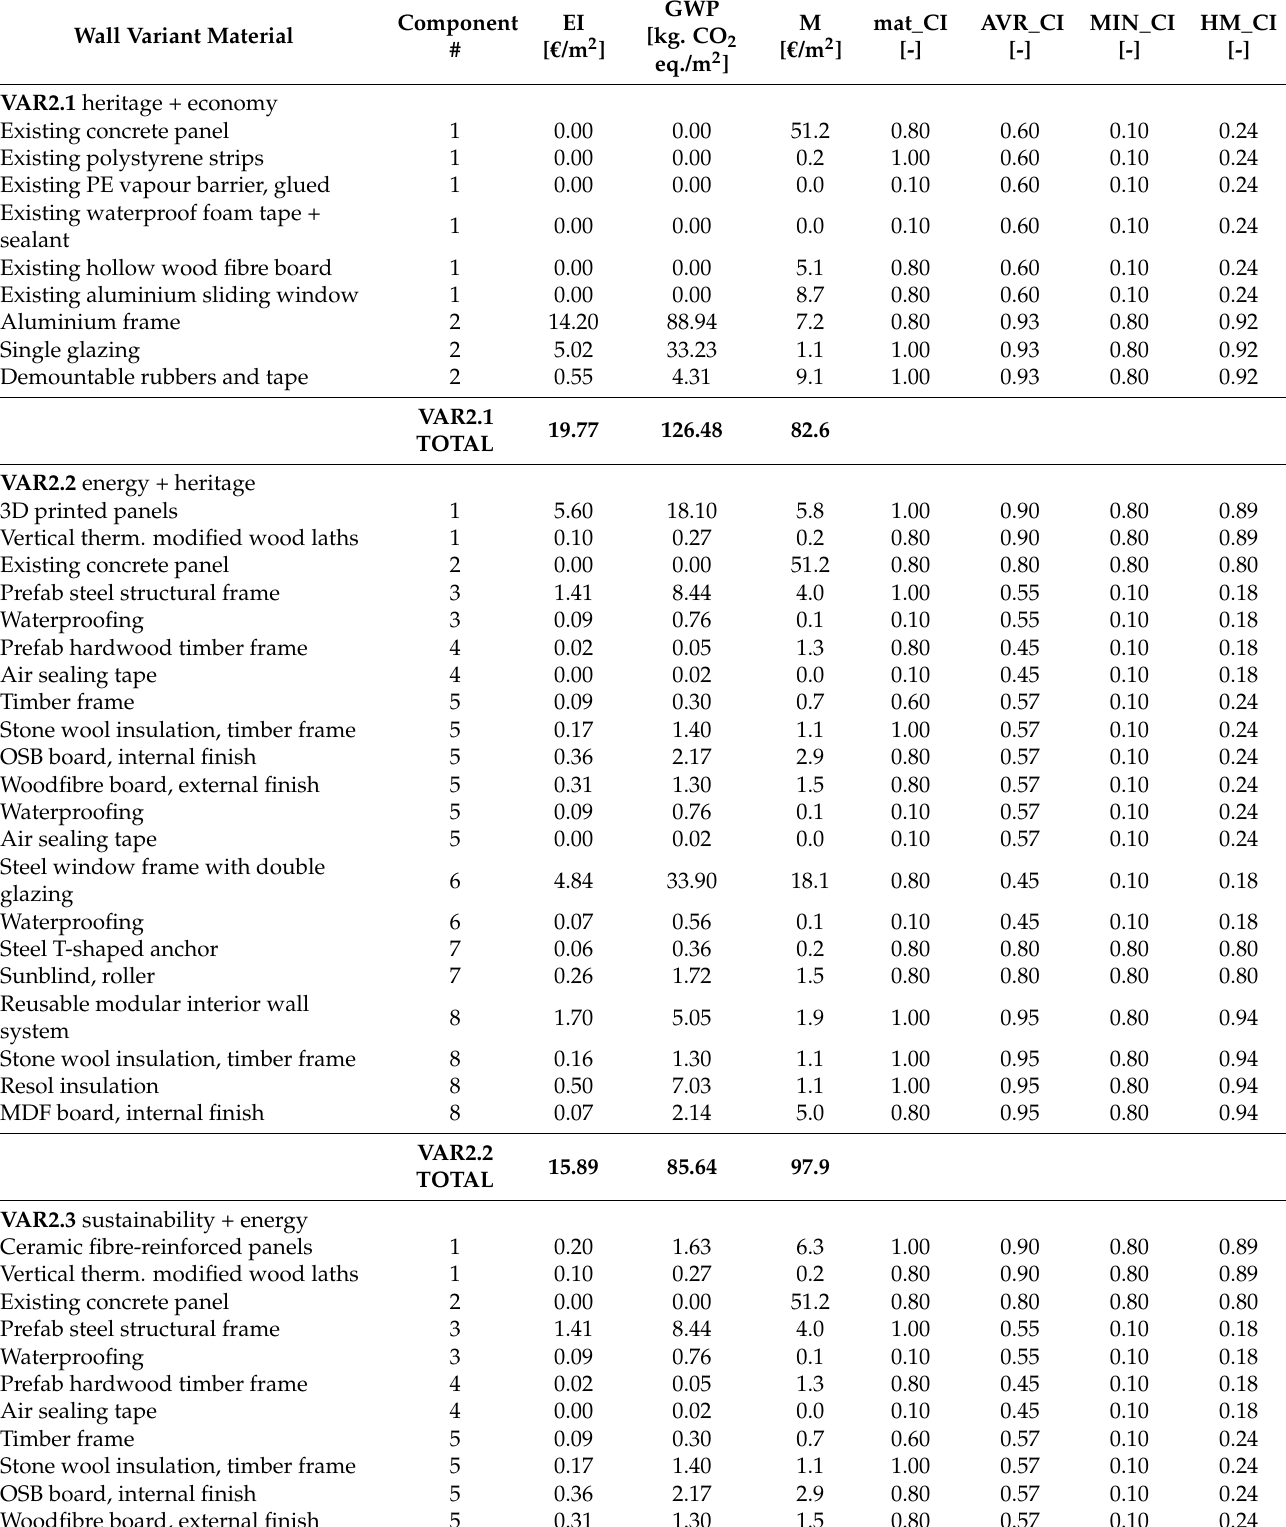
Table 6. Baseline aggregated environmental impact (EI) results, global warming potential (GWP), mass input flows (M), and four options of connection indexes (CI; mat_CI = CI on the material level, AVR_CI = average component CI, MIN_CI = the minimal CI within a component, HM_CI = harmonic mean component CI) of all external wall variants of case study 2, in absolute